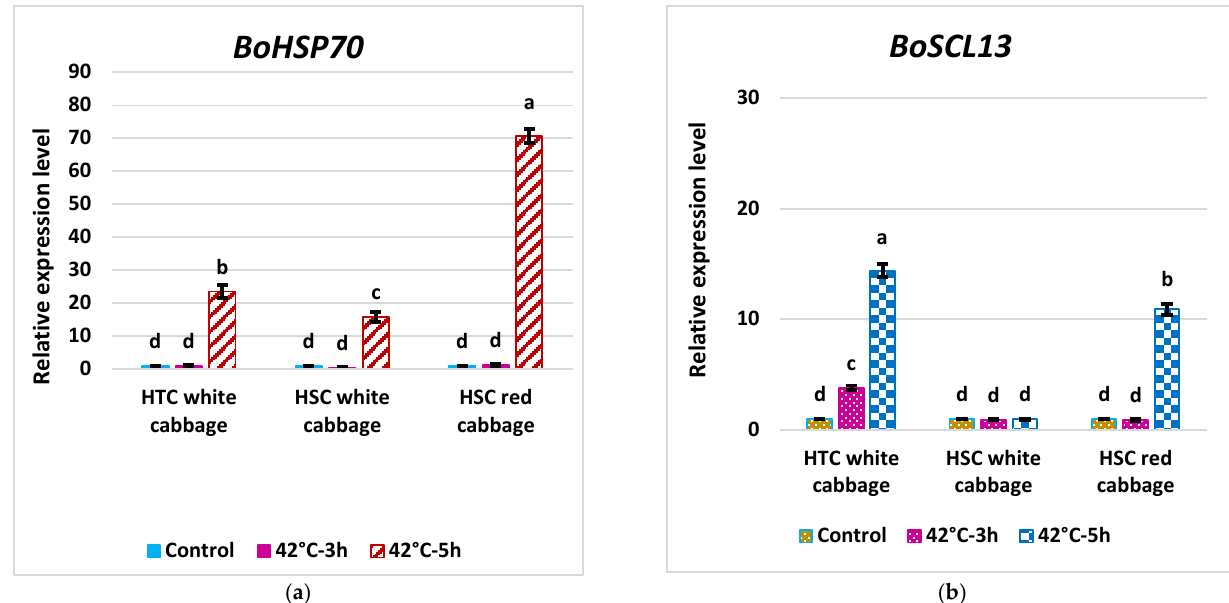
Figure 6. Expression pattern of ( a ) BoHSP70 and ( b ) BoSCL13 as specific marker genes for the heat tolerance trait in cabbage cultivars. Four-week-old plants were HS treated at 42 °C for 0, 3 and 5 h. The expression levels at 0h were defined as 1.0 and non-stress condition (control). Bars denote the mean ± SE ( n = 3). Mean values within each cultivar with different letters are significantly different based on Tukey’s HSD test at p < 0.05.